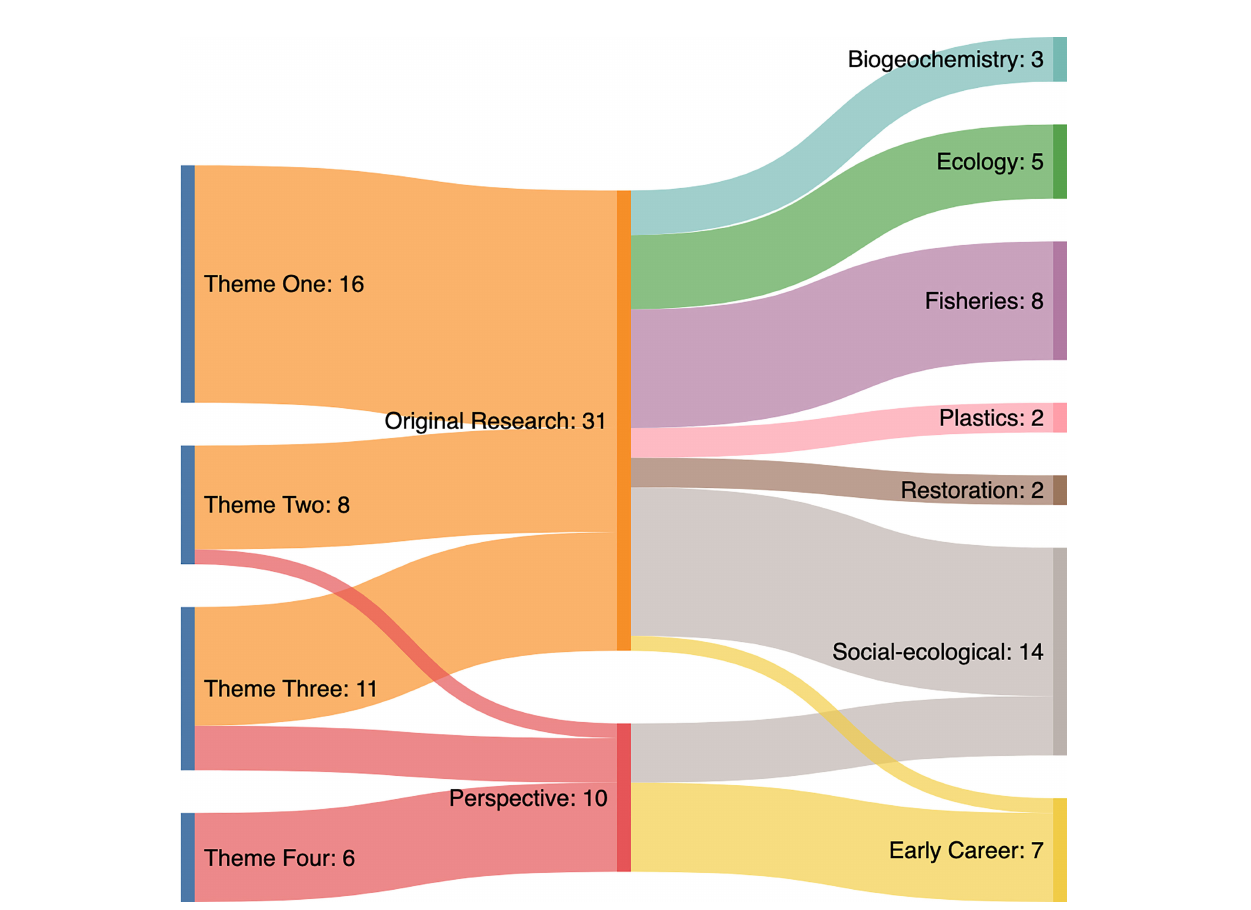
FIGURE 1 | Sankey diagram summarising the 41 articles contributed to this Research Topic (source: http://sankeymatic.com/build/). Diagram shows the distribution of articles across identi fi ed themes (left), whether they were an original research article or perspective piece (middle), and the general discipline or topic of the article (right). Numbers represent the number of papers in each